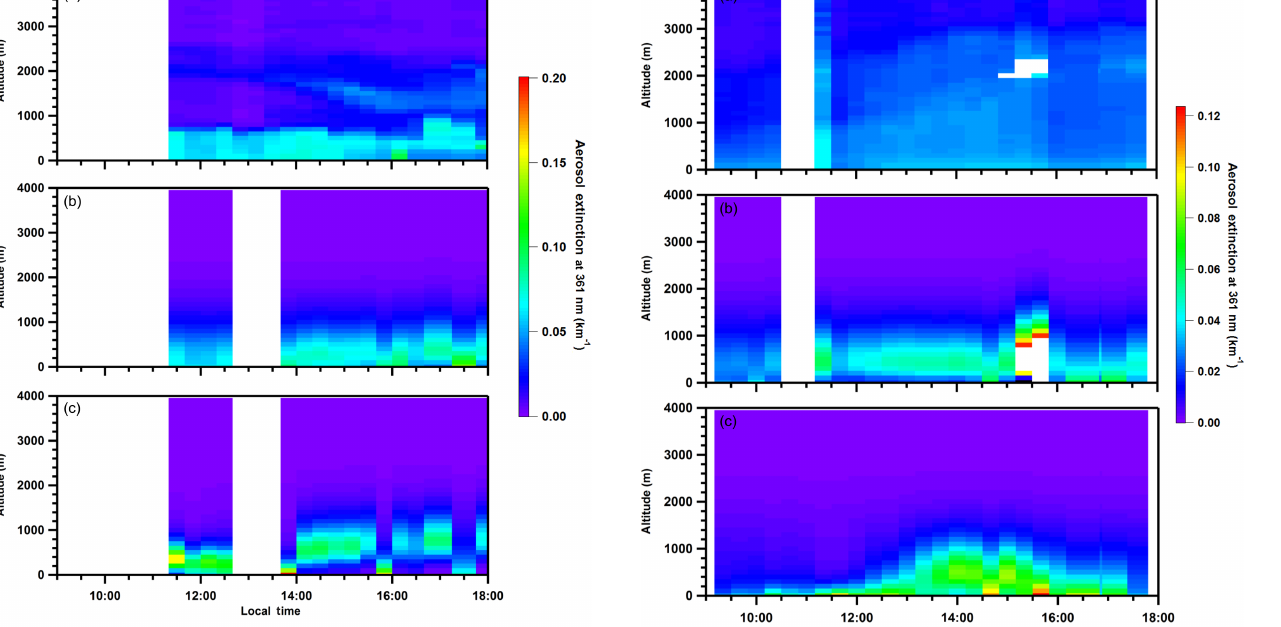
Figure 16. The 5 September vertical profiles of aerosol extinction (361nm) from averaged lidar (a) , smoothed lidar (b) , and MAX- DOAS retrieved measurements (c) . Omitted data in the afternoon were measurements of cirrus